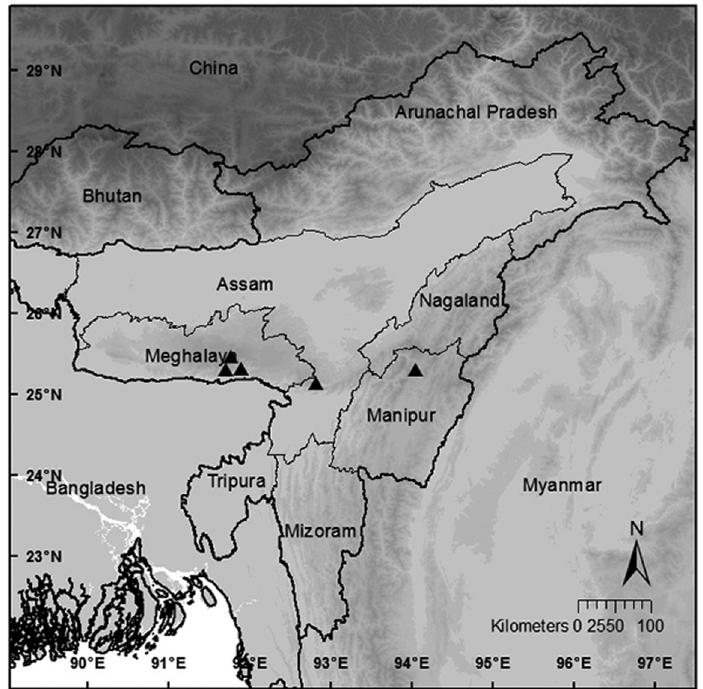
Fig. 21. Map showing the location of B. difformis (Irmsch.) W.C.Leong, C.I Peng & K.F.Chung